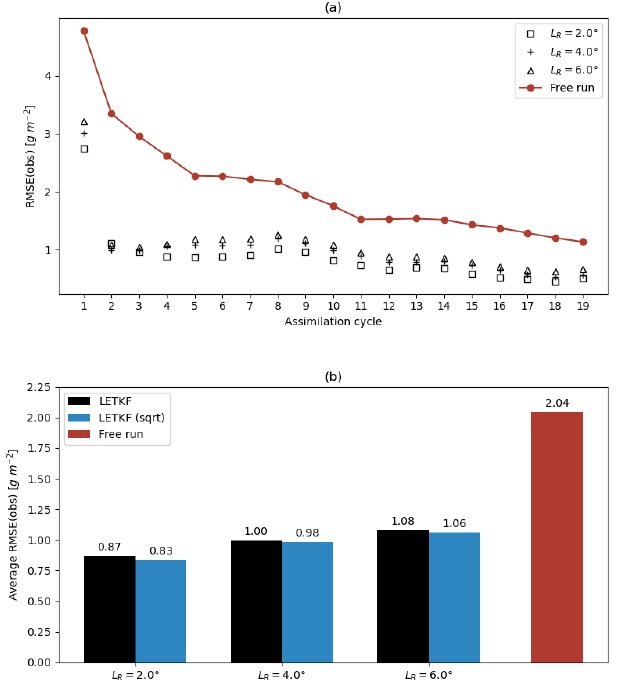
Figure 8. RMSE o computed in the observation space for the Raikoke experiment: (a) time series of RMSE o at analysis times for the free (red line) and LETKF runs for different localisation radii ( L R = 2 ◦ , L R = 4 ◦ and L R = 6 ◦ ) and (b) the same with time- averaged values.